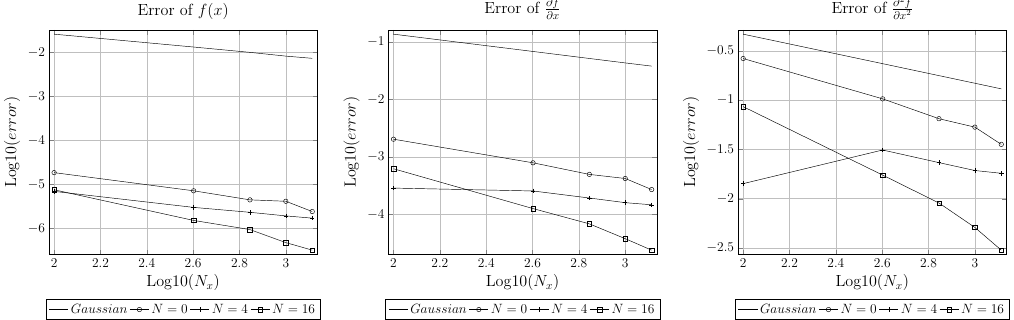
Figure 4. Error of approximating the specified function f ( x ) and its derivatives using the Gaussian RBF approach and Hermite expansion approach as they vary with the mesh size ( N x ). The shape parameter is fixed at 1 e 3. The mesh points are stretched points within the range [ −